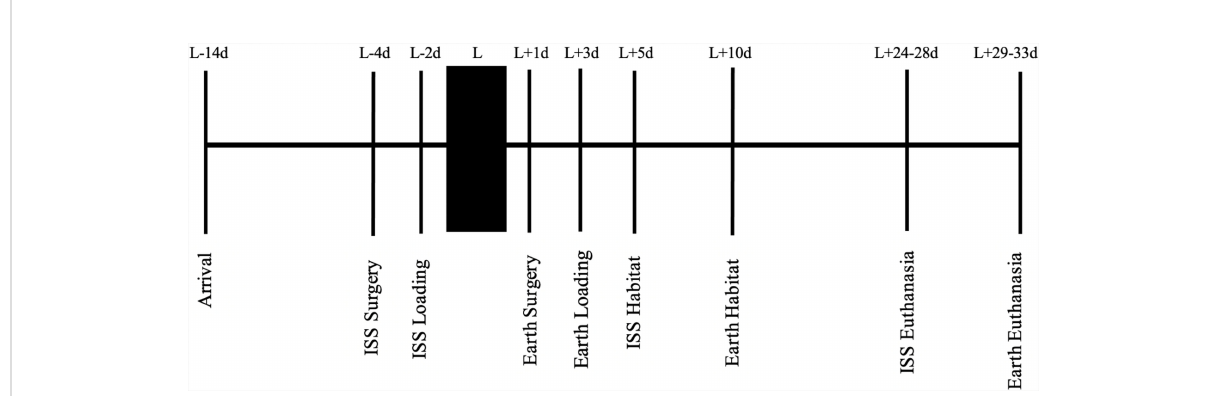
FIGURE 1 A stepwise representation of the experimental timeline, starting with mouse acclimation, to space fl ight launch, and ending with euthanasia. L, launch; d, day; ISS, International Space